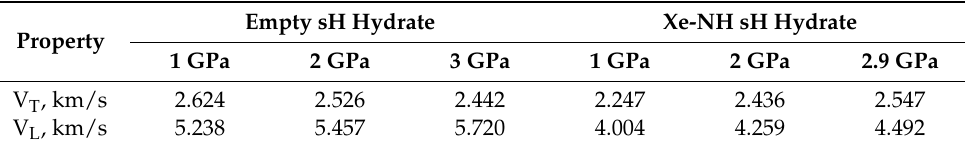
Table 6. Transverse (V T ) and longitudinal (V L ) wave velocities of empty and Xe-NH sH gas hydrates under pressure and at 0